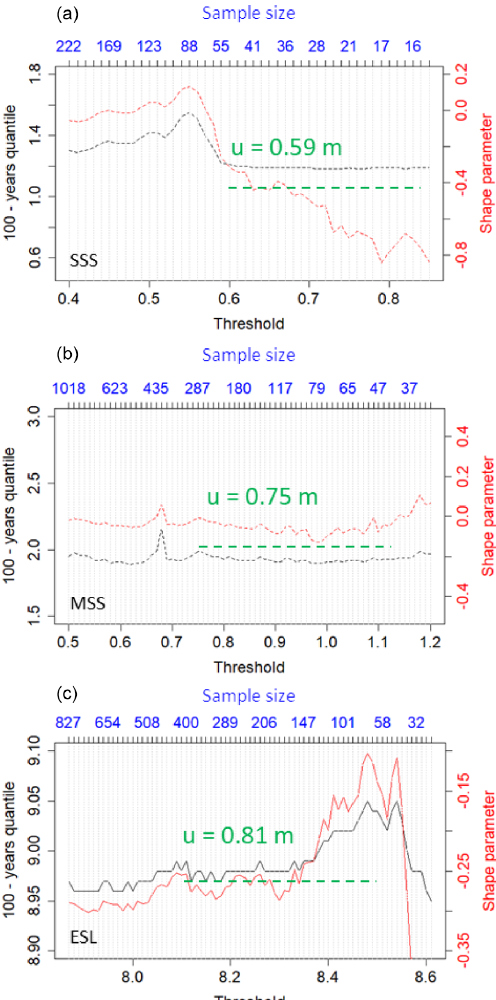
Figure 5. Stability plots for threshold selection: (a) SSSs, (b) MSSs and (c)